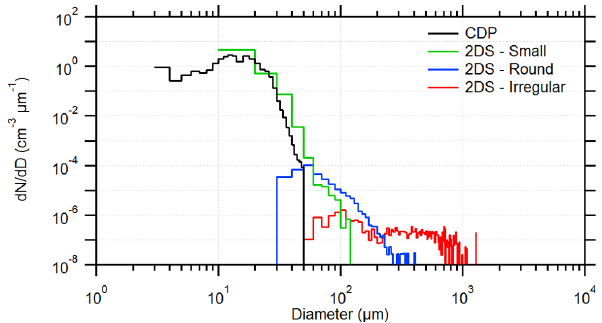
Fig. 12c. Ice particle size distribution from the 2D-S in the con- vective region (15-25km distance from CFARR) in low ( < 1cm − 3 ) cloud droplet number concentration regions.